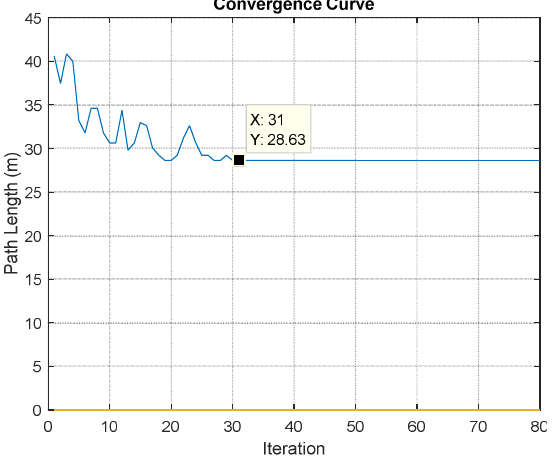
Fig. 21. The Convergence Curve for Experiment 2 From the previous two figure, the mobile robot start avoids static obstacles with the shortest path is (28.63) in iteration (31) with the total computation time equal to (7.838582).